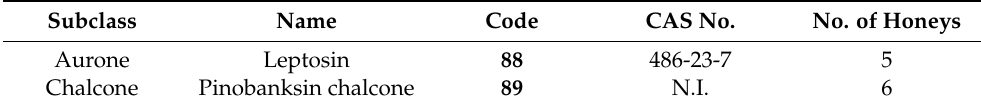
Figure 13. Structure of leptosin ( 88 , Table 8) and of pinobanksin chalcone ( 89 , Table 8). Table 8. Aurones and chalcones reported in monofloral honeys.